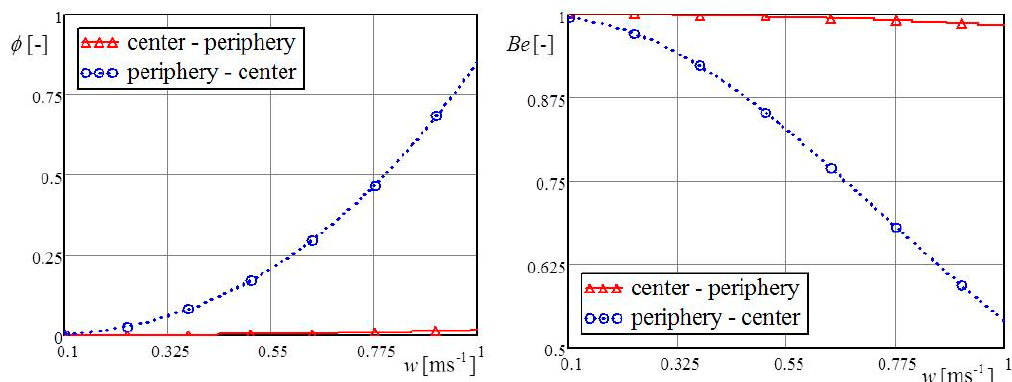
Figure 15. Irreversibility distribution ratio and Bejan number for direct and counter impinging liquid jet. Diagrams of the effectiveness of the direct and counter impinging liquid on the heating bottom were established in accordance with Equation (15). Higher values of effectiveness happened with direct liquid impinging on the heated bottom. Higher velocities of liquid intensified the heat exchange, thus causing the vertical part of the annular cavity to cool faster, leading to lower values for effectiveness, as shown in Figure